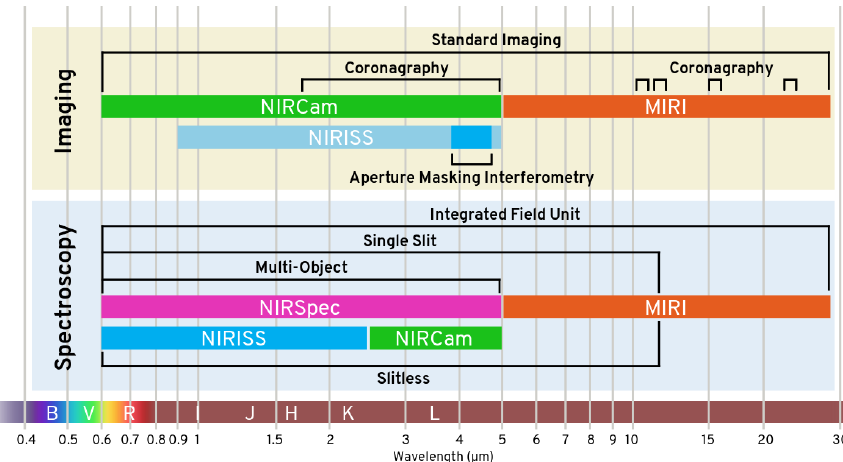
Figure 1. James Webb Space Telescope (JWST) instruments/capabilities at a glance (from http://www.stsci. edu/jwst/instrumentation). Detailed information can be found at